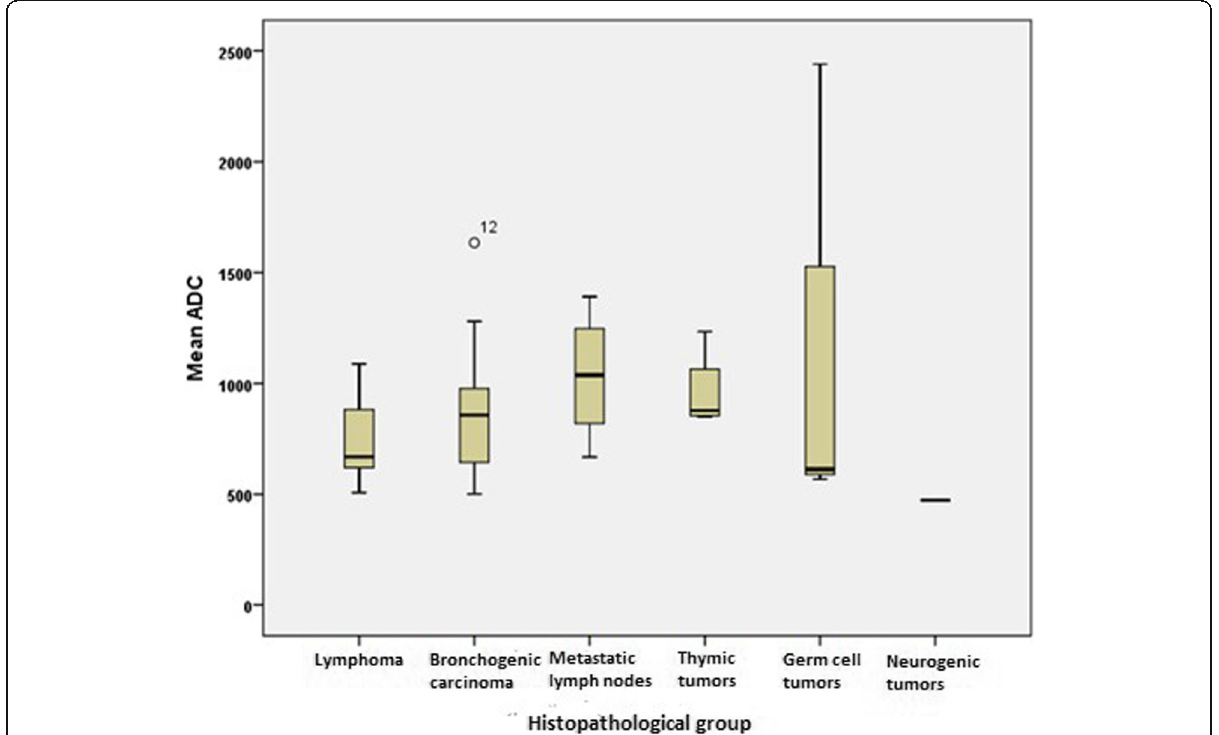
Fig. 4 Bar-and-Whisker plot: ADC mean values of the different histopathological